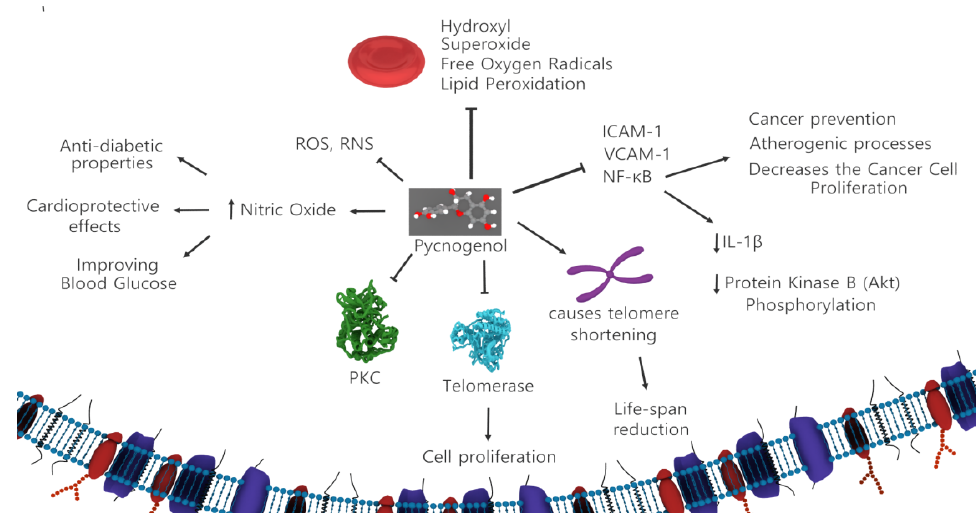
Figure 3. Mechanism of pycnogenol anticancer and antioxidant action. Pycnogenol can inhibit PKC and telomerase in cancer cells for life-span reduction. Furthermore, by reducing NF κ B activation, VCAM-1 and ICAM-1 can prevent cancer. Pycnogenol has anti-diabetic and cardioprotective effects through increasing nitric oxide levels and reducing lipid peroxidation.